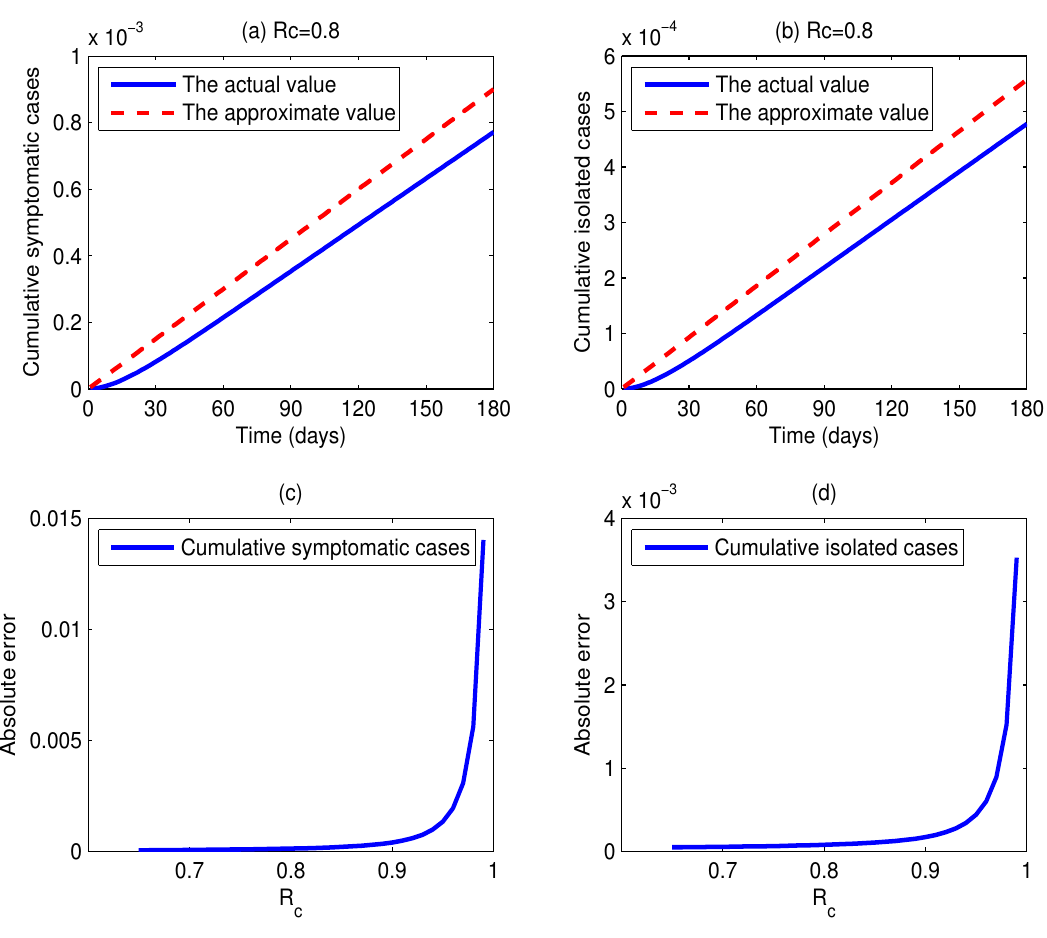
; ( d ) plots of the absolute errors of the c . c